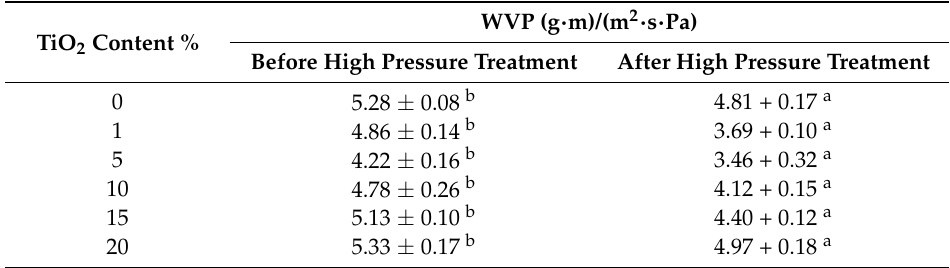
Table 3. Water vapor permeability of composite films with different ratios of nanoparticles before and after high pressure